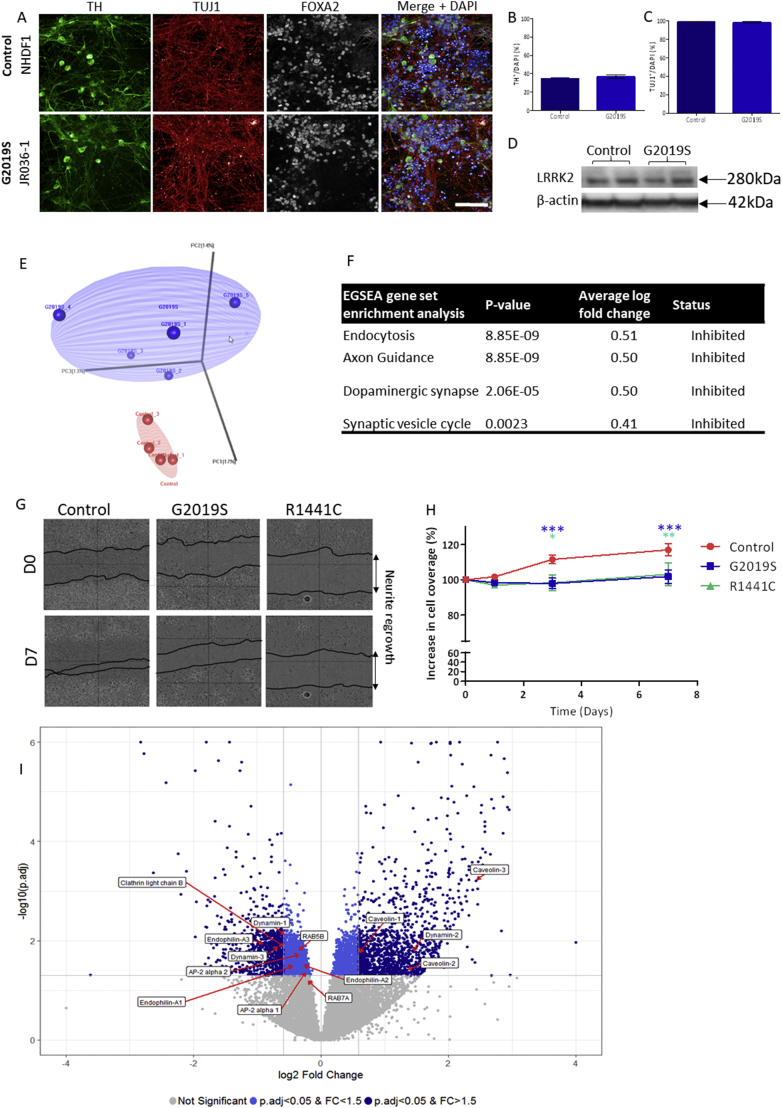
Integrated transcriptomic and proteomic analysis reveals the endocytic pathway to be the most dysregulated pathway in iPSC derived dopaminergic neurons from LRRK2-G2019S PD.(A) Representative images of iPSC-derived dopaminergic neurons showing staining for TH, Tuj1 and FOXA2 with the percentage of TH and TUJ1 positive cells demonstrated for both controls and LRRK2-G2019S in B and C. Scale bar 100 μm. (D) Representative western blots demonstrating LRRK2 expression in 35 DIV iPSC-derived dopaminergic cultures. Unpaired t-test. (E) PCA plot of integrated transcriptomic and proteomic data demonstrating the separation of iPSC-derived dopaminergic cultures from five G2019S patients and four controls. (F) Integrated proteomics and transcriptomics reveal a number of significantly dysregulated pathways with endocytosis being the most significantly altered. Representative images of neurite regrowth at D0 and D7 of scratch assay (G, H) showing significantly reduced regrowth into the scratch area in both LRRK2-G2019S and LRRK2-R1441C lines compared to controls. *p ≤0.05, **p ≤0.01, ***p ≤0.001 2-way ANOVA. (I) Volcano plot demonstrating fold change and p-values in the combined transcriptomic and proteomics dataset, with key endocytic proteins highlighted.